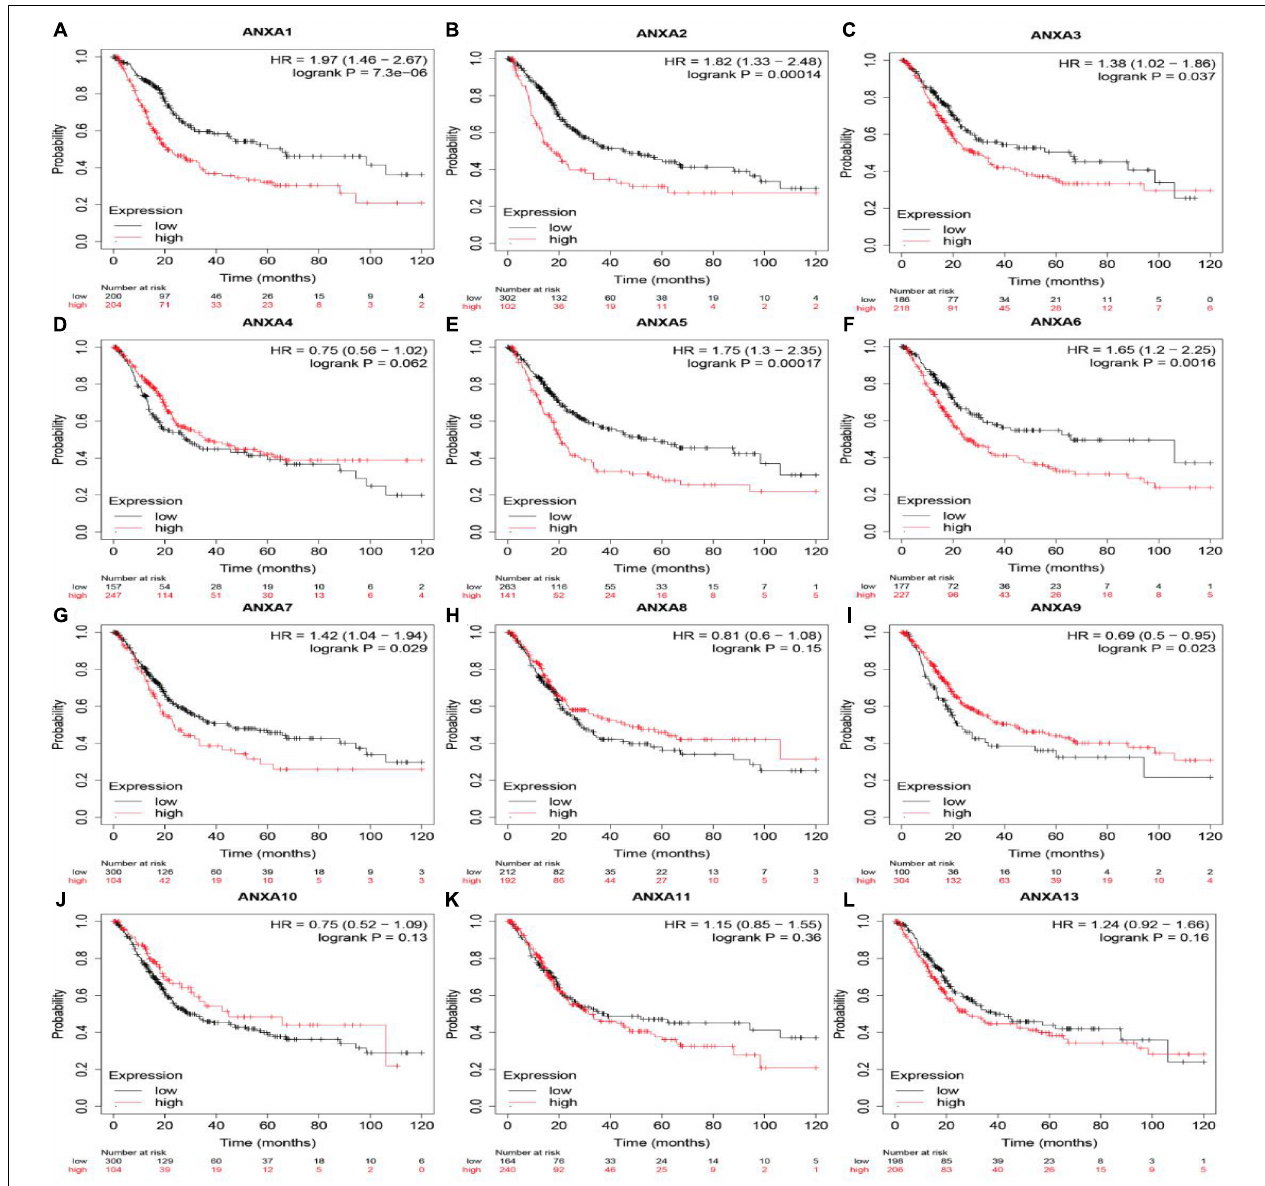
FIGURE 3 | OS of mRNA expression of ANXA family members in BC patients. Survival curves comparing the high and low expression of ANXA family members in BC patients in Kaplan-Meier Plotter (A–L) .